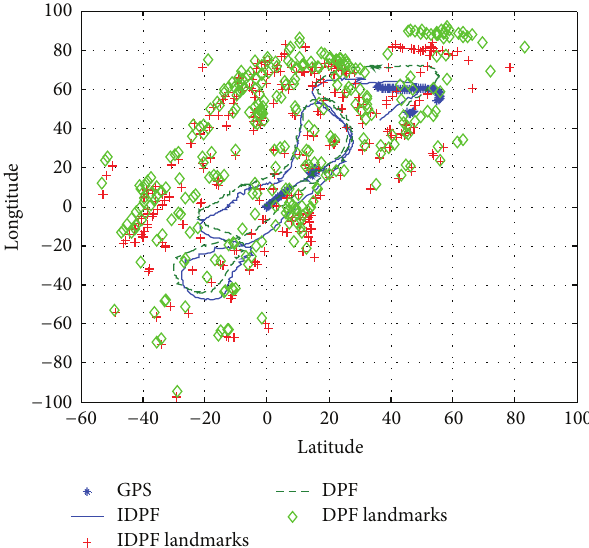
Figure 6: The comparison of estimation results in Experiment 2.